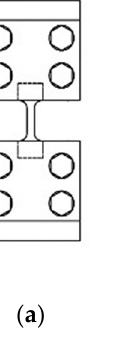
Figure 3. Schematics of the jigs for the ( a ) uniaxial tensile test and ( b ) four-point flexural test.